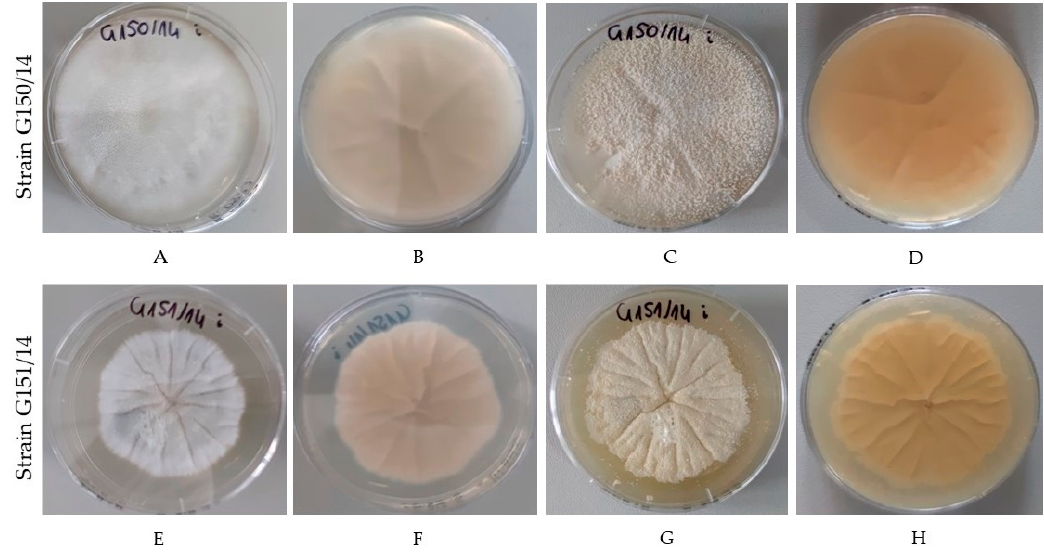
Figure 2. Neosartorya spp. growth on Potato Dextrose Agar with antibiotics (streptomycin, chlortetracycline). Strain G150/14 ( A – D ) after 4 days of culturing at 30 °C ( A , B ) and a month after ( C , D ). Strain G151/14 ( E – H ) after 4 days of culturing at 30 °C ( E , F ) and a month after ( G , H ). The number of strains: G150/14; G150/14; G151/14; G151/14 are visible on the plates presented on the